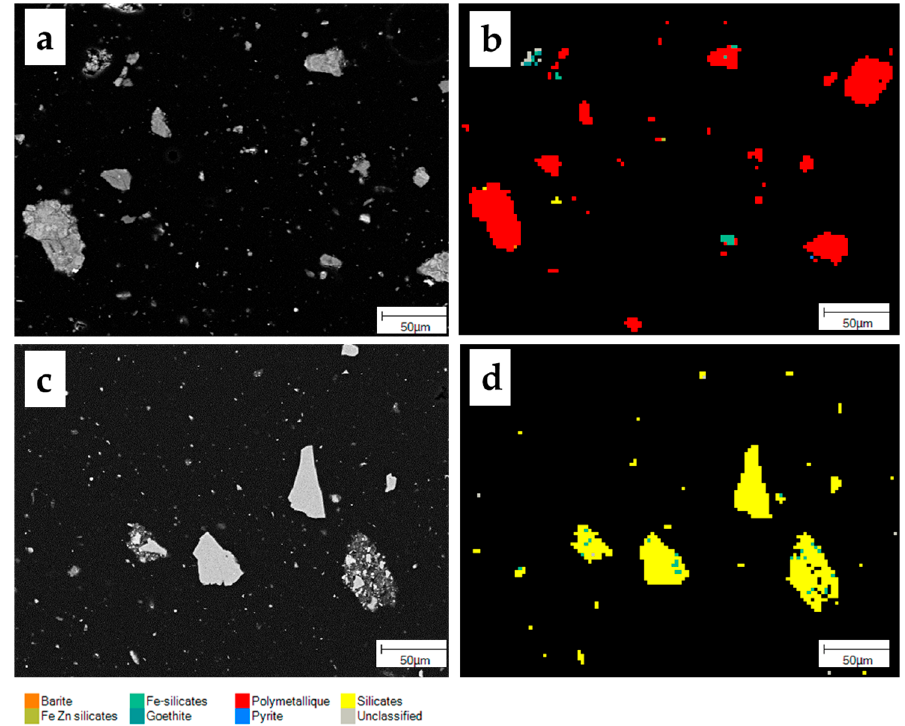
Figure 8. False-color mineral maps as obtained by automated mineralogy of selected areas of ( a , b ) feed (PN (67%) and SMS (33%)) and( c , d ) residue after 48 h.